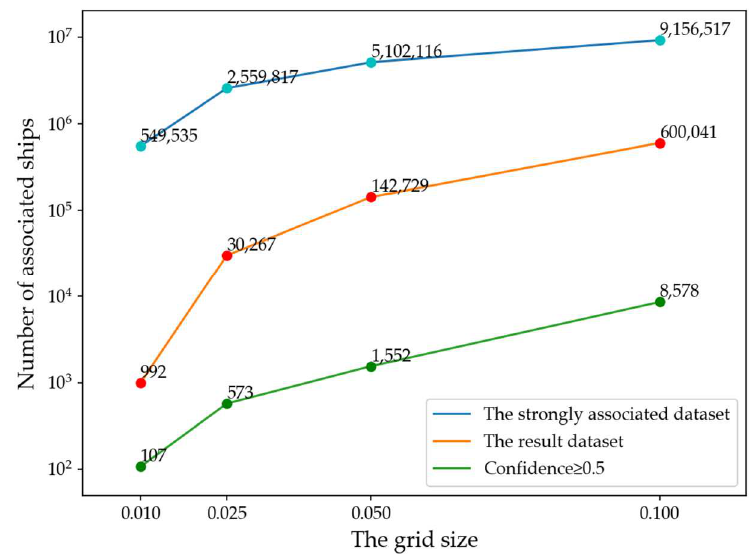
Figure 7. Influence analysis of the grid